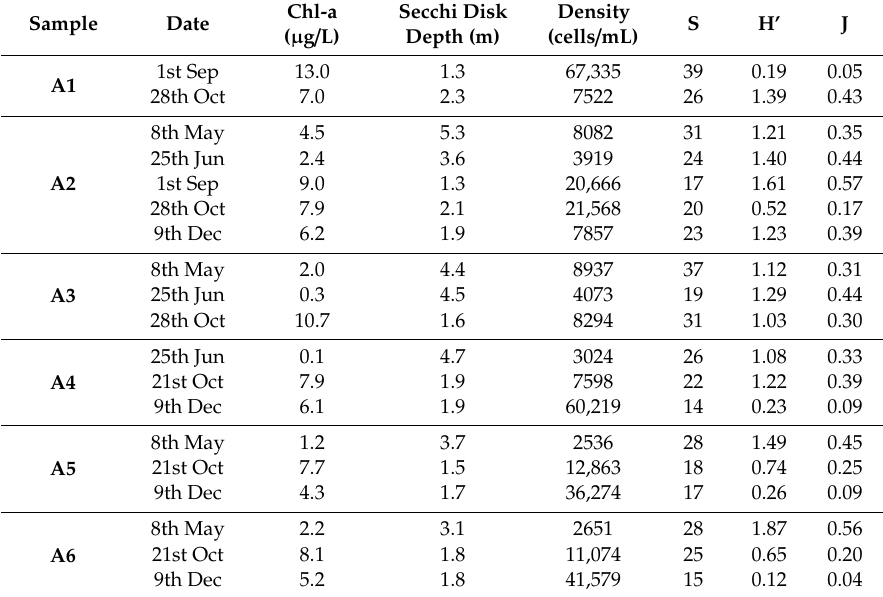
Table 1. Descriptive and diversity analysis. Values of chlorophyll-a (Chl-a) concentration, transparency (Secchi disk depth), phytoplankton density of the sample (Density). For the analysis of diversity, data on the richness (S), diversity (H (cid:48) ), and equitability (J) have been included. Sampling points as indicated in Figure